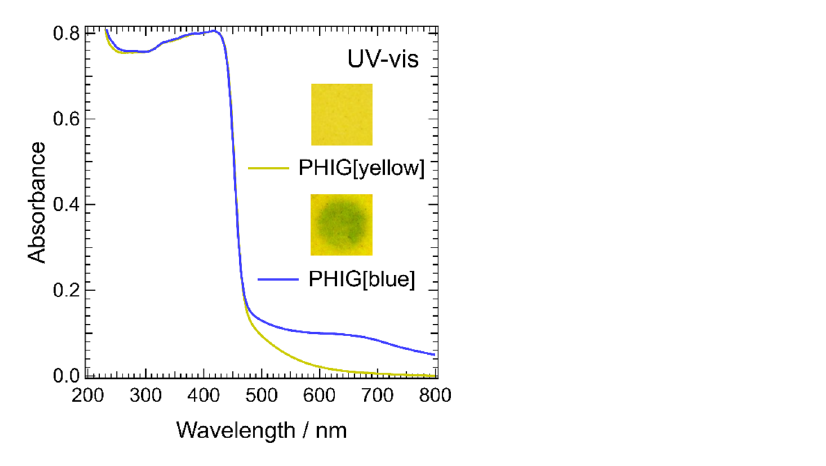
Figure 2. UV–Vis spectra of PHIG with the ionic liquid [Bmim]PF 6 . PHIG[yellow] means the sample before white-light irradiation, PHI[blue] means the sample after the irradiation for 30 min. Photos in the figure represent PHIG[yellow] and PHIG[blue].